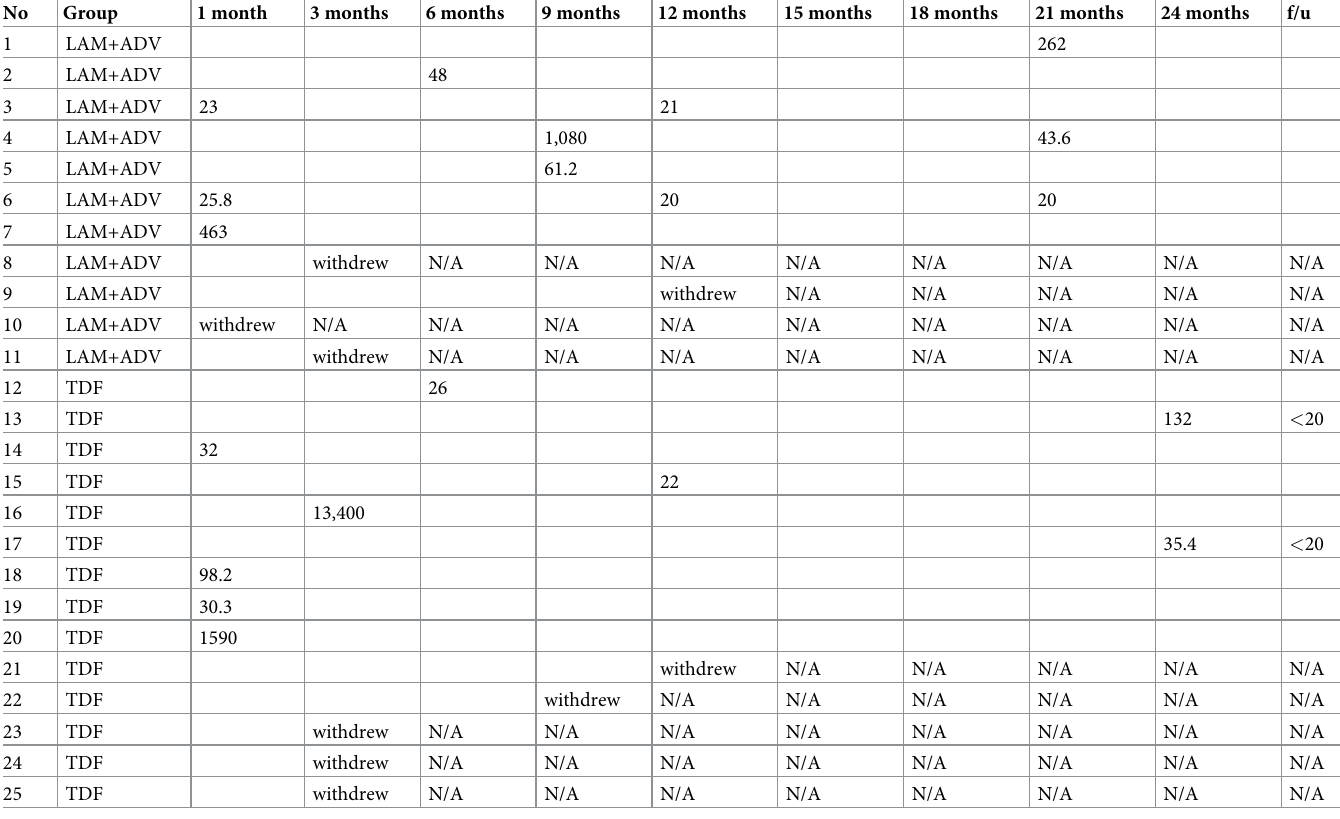
Table 3. Details of the 25 patients with transient virologic rebound or withdrawal from the